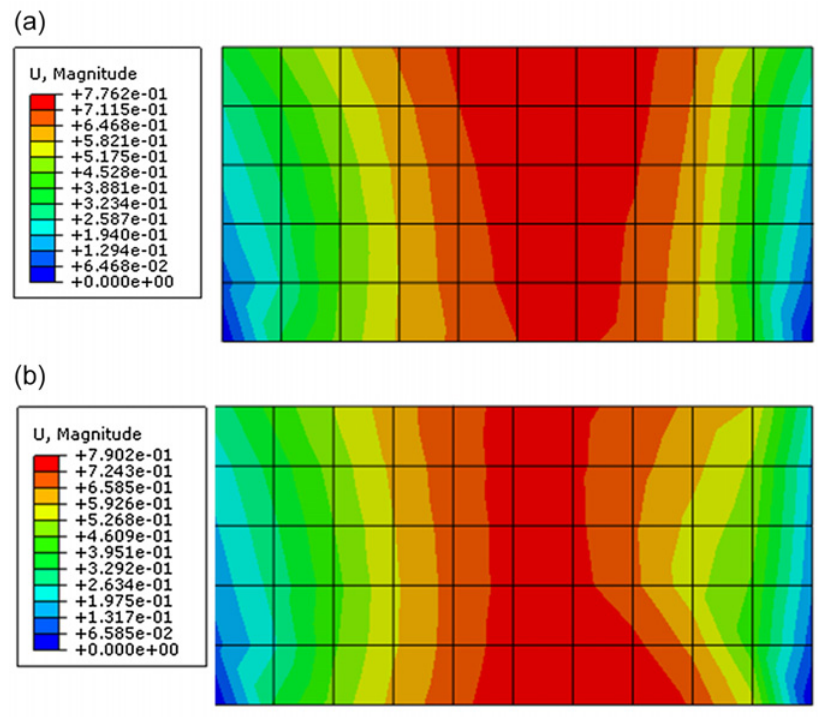
Fig 15. The displacement contour of the green region of the rectangle foundation calculated by different constitutive models(m) ((a)The contour for magnitude of displacement calculated by proposed constitutive model; (b) The contour for magnitude of displacement contour calculated by ubiquitous-joint model)